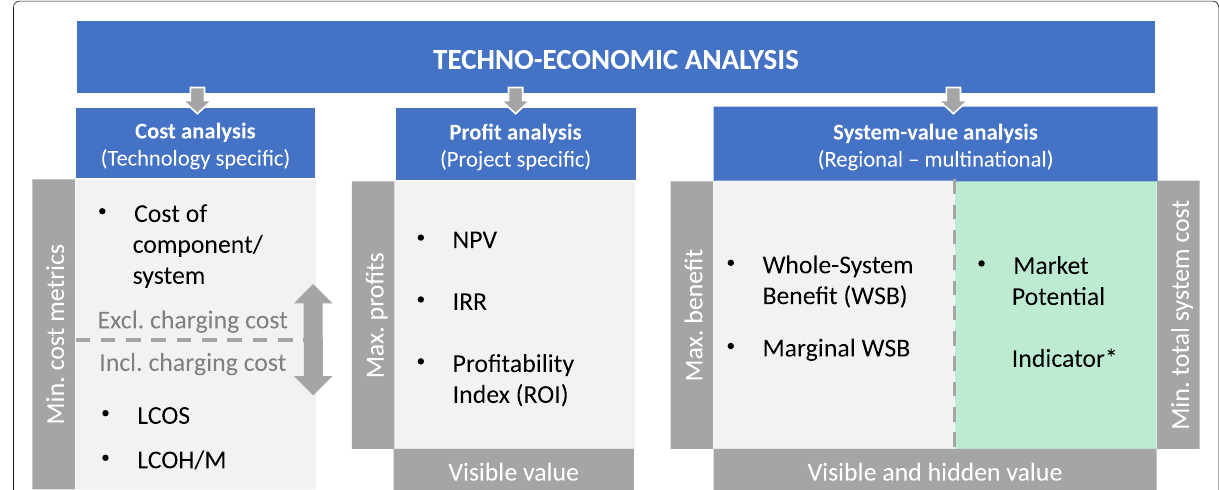
Fig. 1 Classification of current techno-economic analysis methods in the context of energy storage. *Market potential indicator is a suggested decision metric and part of the newly introduced market potential method. The abbreviations mean the following: levelised cost of storage (LCOS), levelised cost of hydrogen or methane (LCOH/M), net present value (NPV), internal rate of return (IRR), return of investment